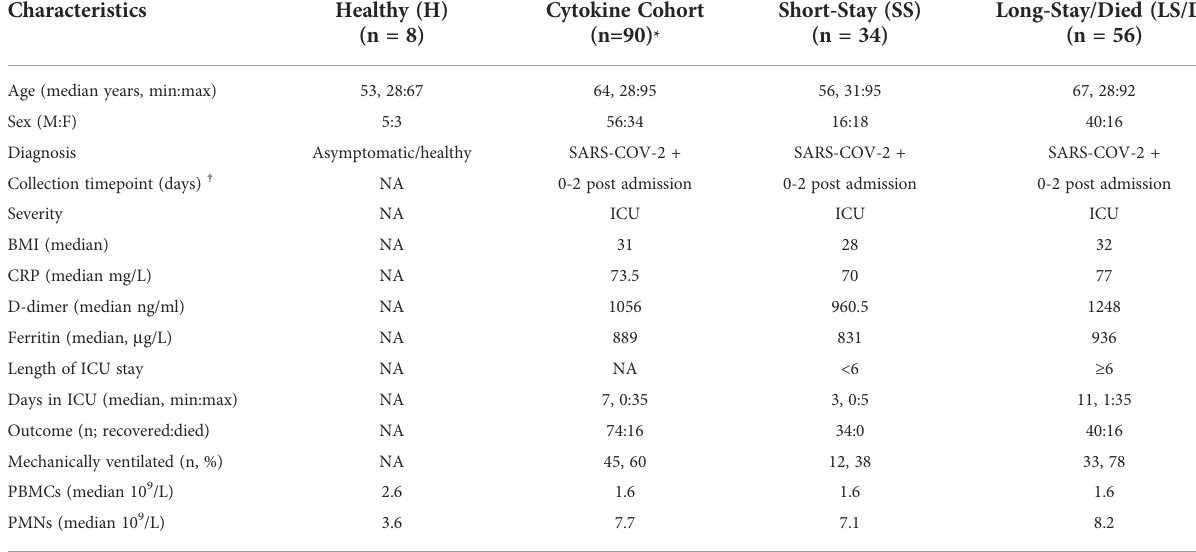
TABLE 1 Cohort clinical information.